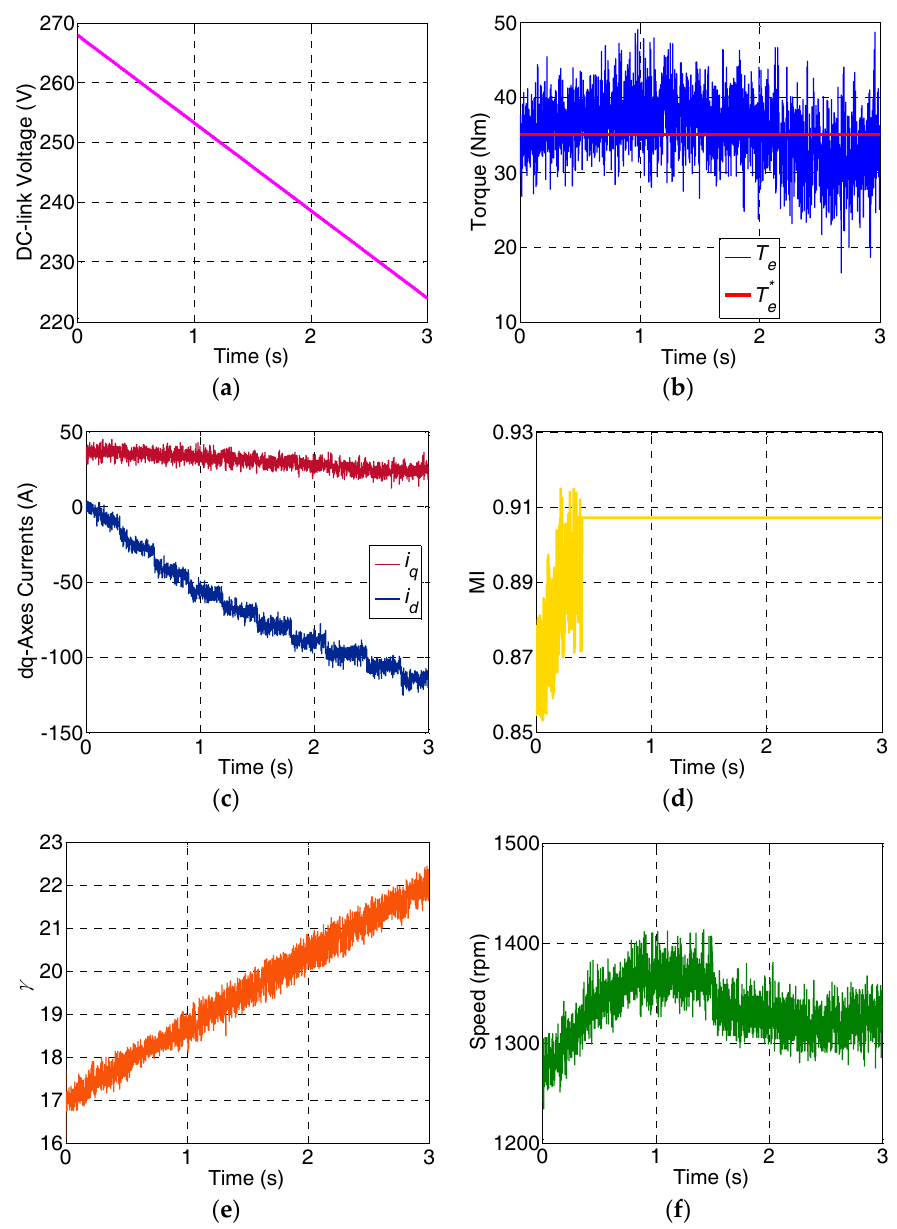
Figure 9. Experiment results under the adjustable DC-link voltage. ( a ) DC-link voltage; ( b ) Torque; ( c ) dq-Axes Currents; ( d ) MI; ( e ) γ ; ( f ) Speed.